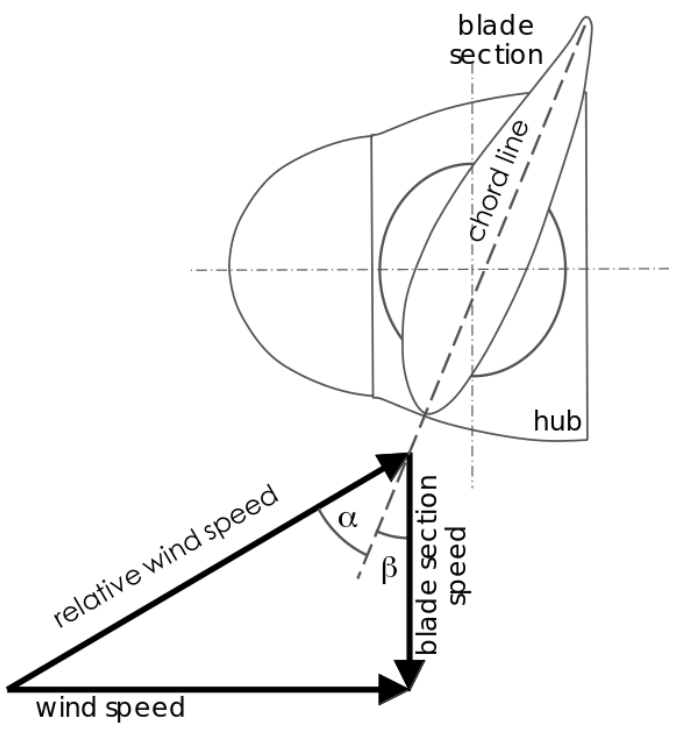
Figure 1. Angle of attack α and pitch angle β for a given blade